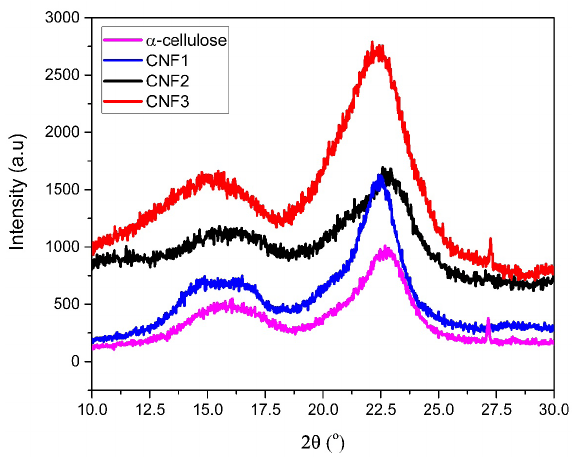
Figure 6: XRD spectra of α-cellulose and